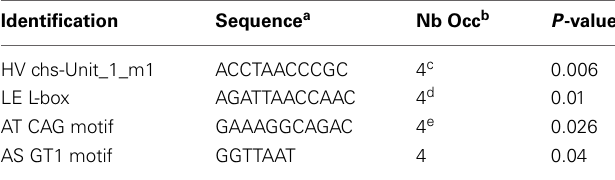
FIGURE 2 | Phylogeny of the 1kb-upstream region of the studied PDF1 s using an alignment free method. Phylogeny analysis of the 1kb-long upstream sequence for the 17 studied PDF1 genes: 10 from A. halleri and 7 from A. thaliana (green boxes). Phylogeny inference was carried out using FFP software (Sims et al., 2009), which involves an alignment-free approach based on k-mer frequencies. The bootstrap value obtained with 100 replicates is indicated for each clade. Strongly supported clades (bootstrap support ≥ 95%) are indicated by a red rectangle. These supported clades were consistently recovered when the analysis was conducted with 500bp upstream restriction sequences. Table 2 | Identification of motifs over-represented in 500bp and 1kb-upstream regions of PDF1 s responding to